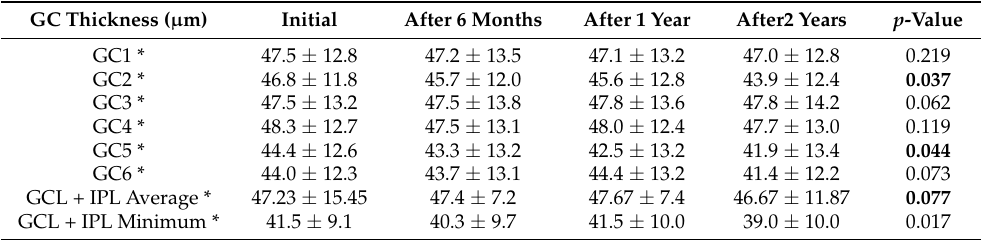
Table 2. Mean values of ganglion cell values in group of patients that received multiple anti-VEGF intravitreal injections during a two year follow